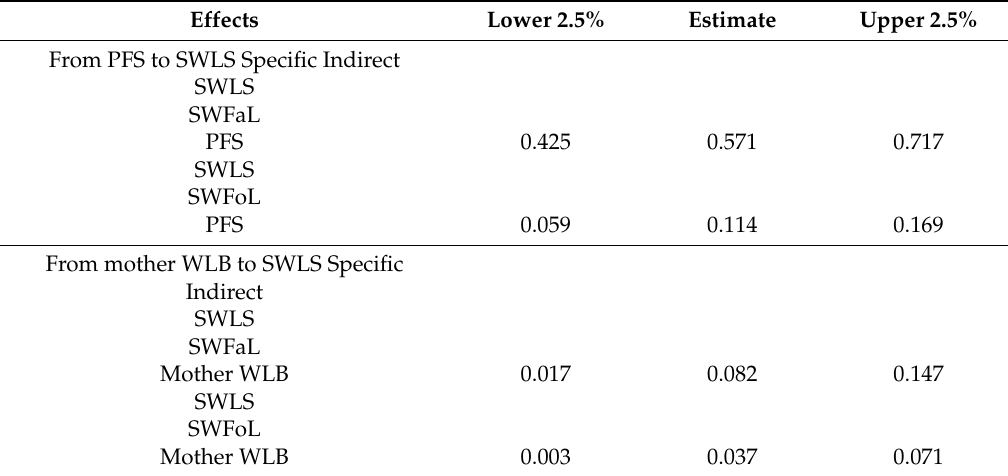
Table 3. Bias-Corrected confidence intervals of specific mediation effects in the model that includes the mothers’ work-life balance (Mother